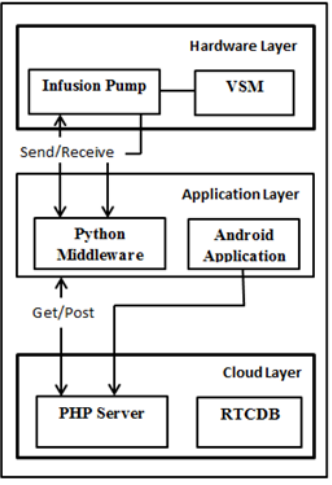
Figure 4. Three Layer Architectural Model for Patient